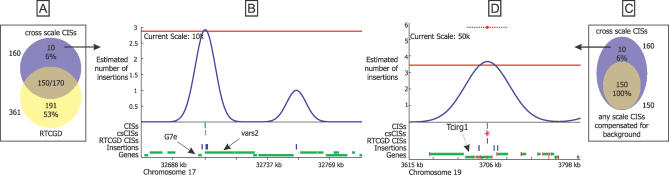
Example of Novel CIS and Background Corrected CIS(A) Venn diagram comparing the csCISs and the CISs in the RTCGD. For reasons explained in Figure 7, the intersection shows two counts.(B) An example of a CIS that consists of three insertions from three independent screens, and therefore is only detected when integrally analyzing the data.(C) Venn diagram comparing the csCISs with and without applying background correction.(D) An example of a csCIS, that was also included in the RTCGD, and is rejected based on the background-corrected threshold. The small vertical bars (red) in the genes denote the 5′ ends of genes, and a star denotes a corrected CIS. Since we are only interested in correcting regions that are putative CISs, a background-corrected threshold is only computed for peaks in the estimated number of insertions. The corrected threshold is given by the horizontal dotted line above the peak.